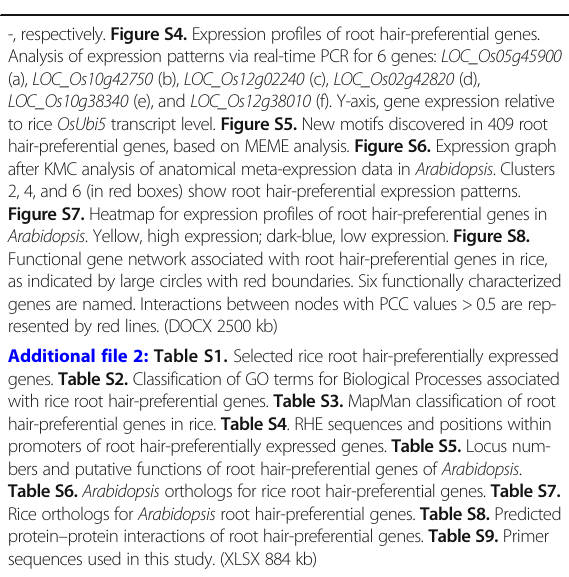
-, respectively. Figure S4. Expression profiles of root hair-preferential genes. Analysis of expression patterns via real-time PCR for 6 genes: LOC_Os05g45900